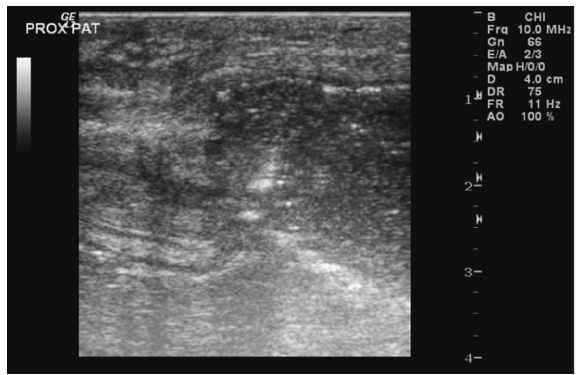
Figure 2: Ultrasound of the left knee showing disruption of the quadriceps tendon and fluid